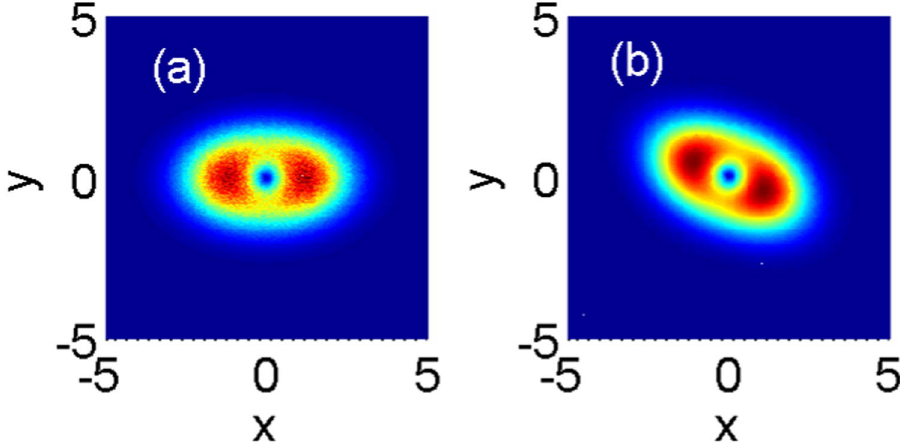
Figure 5. First-order mode of the spiraling elliptic Hermite-Gaussian solitons [i.e. the soliton profiles in Fig. 1(b)] with 20% random noises ( a ), and the profile at the propagation distance z = 20 ( b